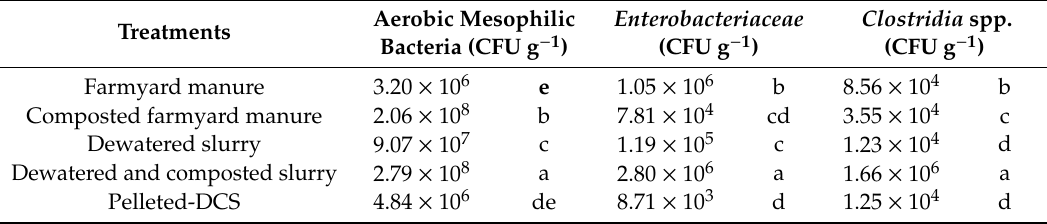
Table 2. Main microbiological parameters assessed on raw and processed livestock manures.